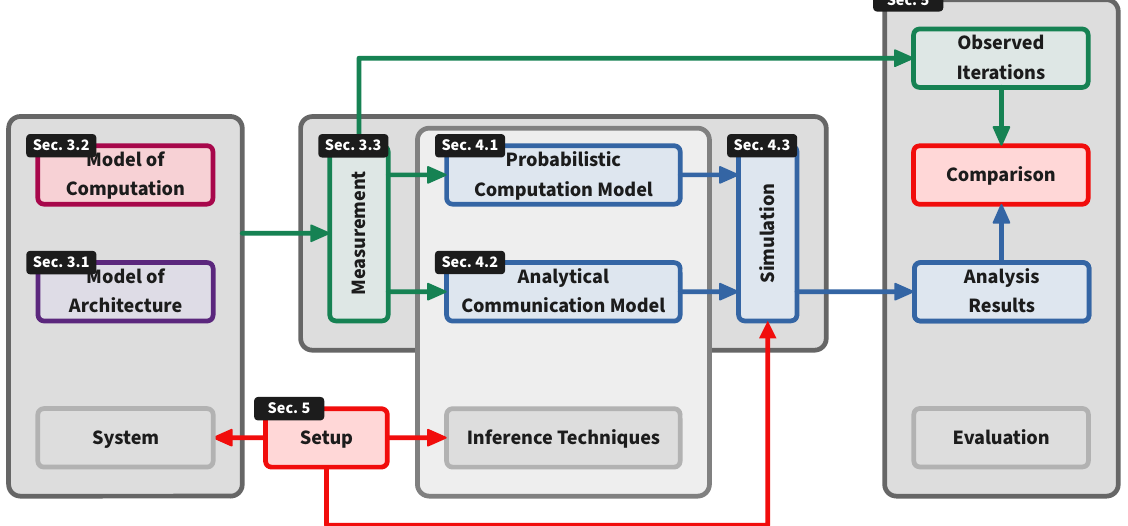
Figure 1. Workflow showing all modeling, characterization and evaluation